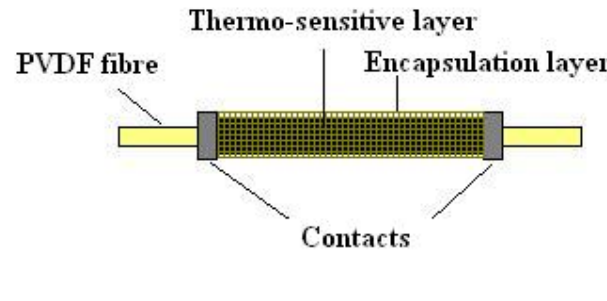
Figure 2. Thermistor